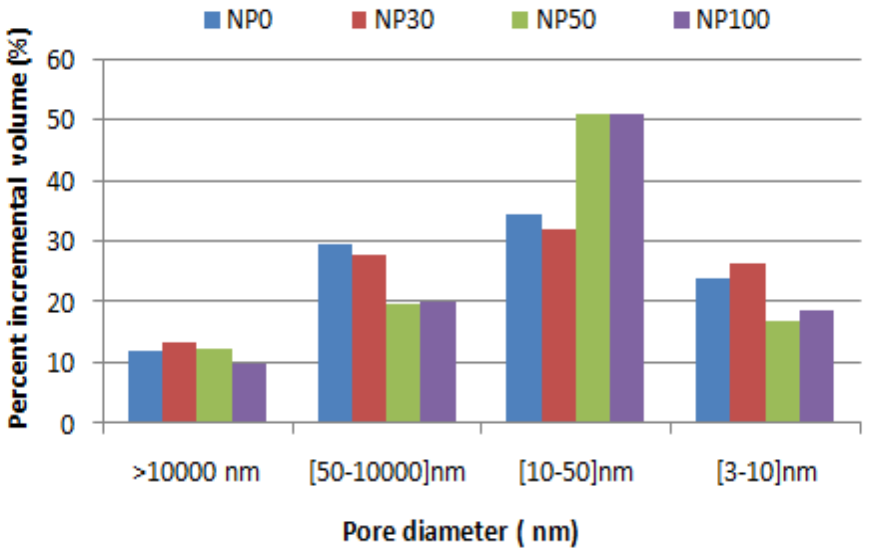
Figure 7. The pore percentage of new pastes (NP) for different pore diameter ranges.